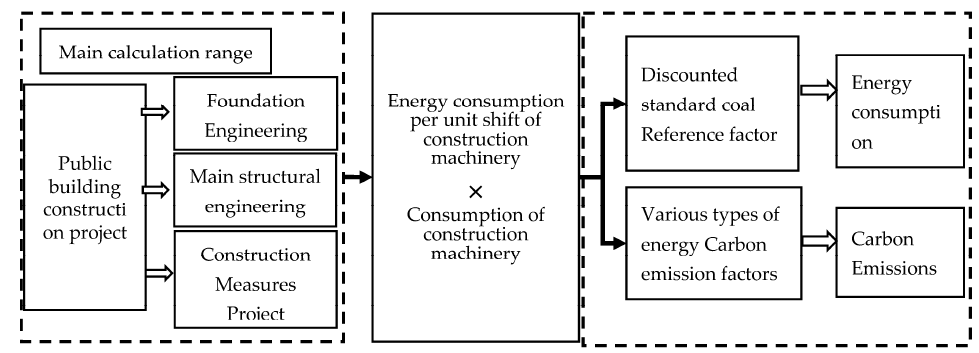
Figure 1. Main calculation structure and content of energy consumption and carbon emissions in the construction phase.